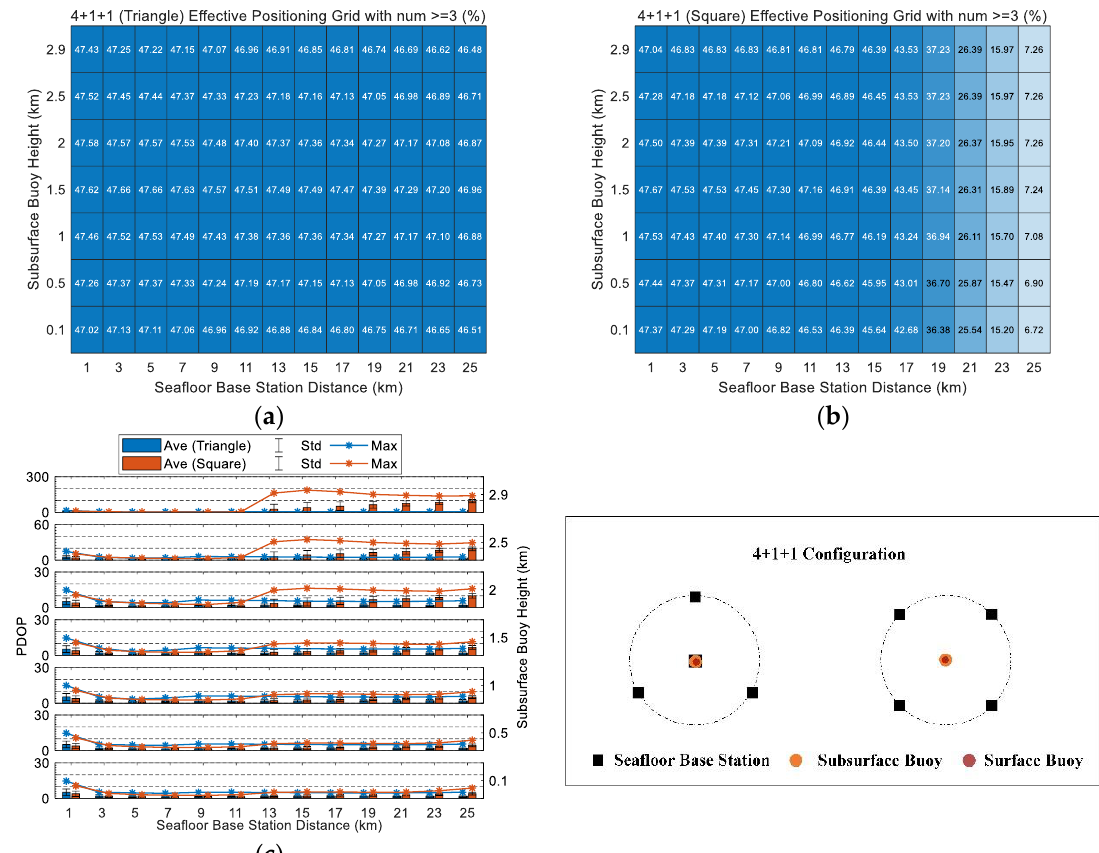
Figure 5. User positioning indicators of the “4+1+1” network configuration. The geometries of the seafloor base station arrays are triangular-center-form array and square-form array. ( a , b ) Heat maps of the percentage of EPGs with the number of available base stations ≥ 3; ( c ) average, standard deviation, and maximum of PDOP—the box denotes the average, the black vertical line denotes the standard deviation, and the asterisk line denotes the maximum